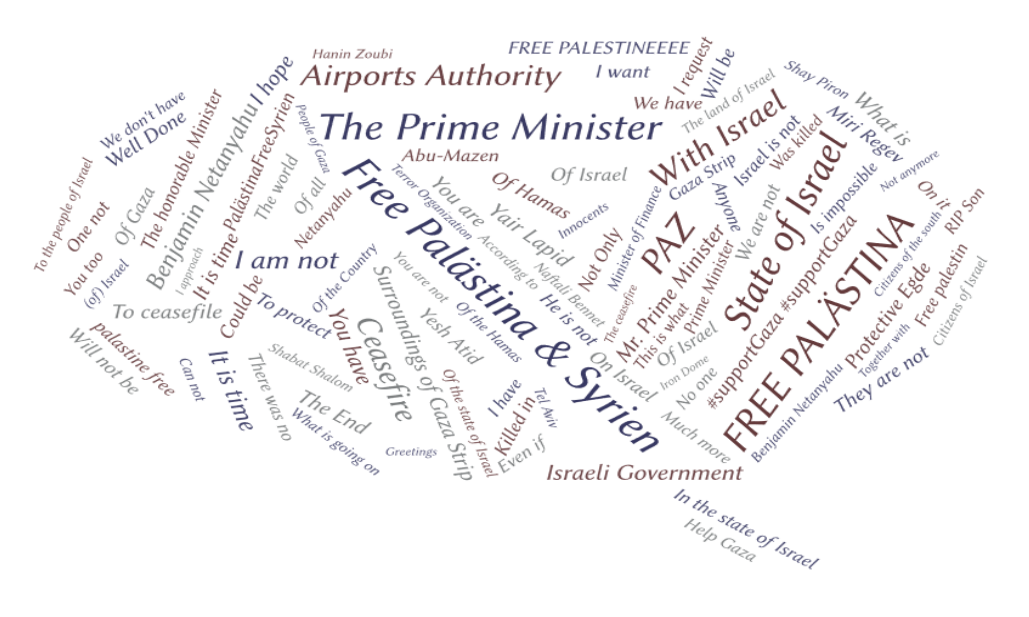
Figure 1: Word cloud of 100 most frequent terms in the emergency corpus. Size represents scale